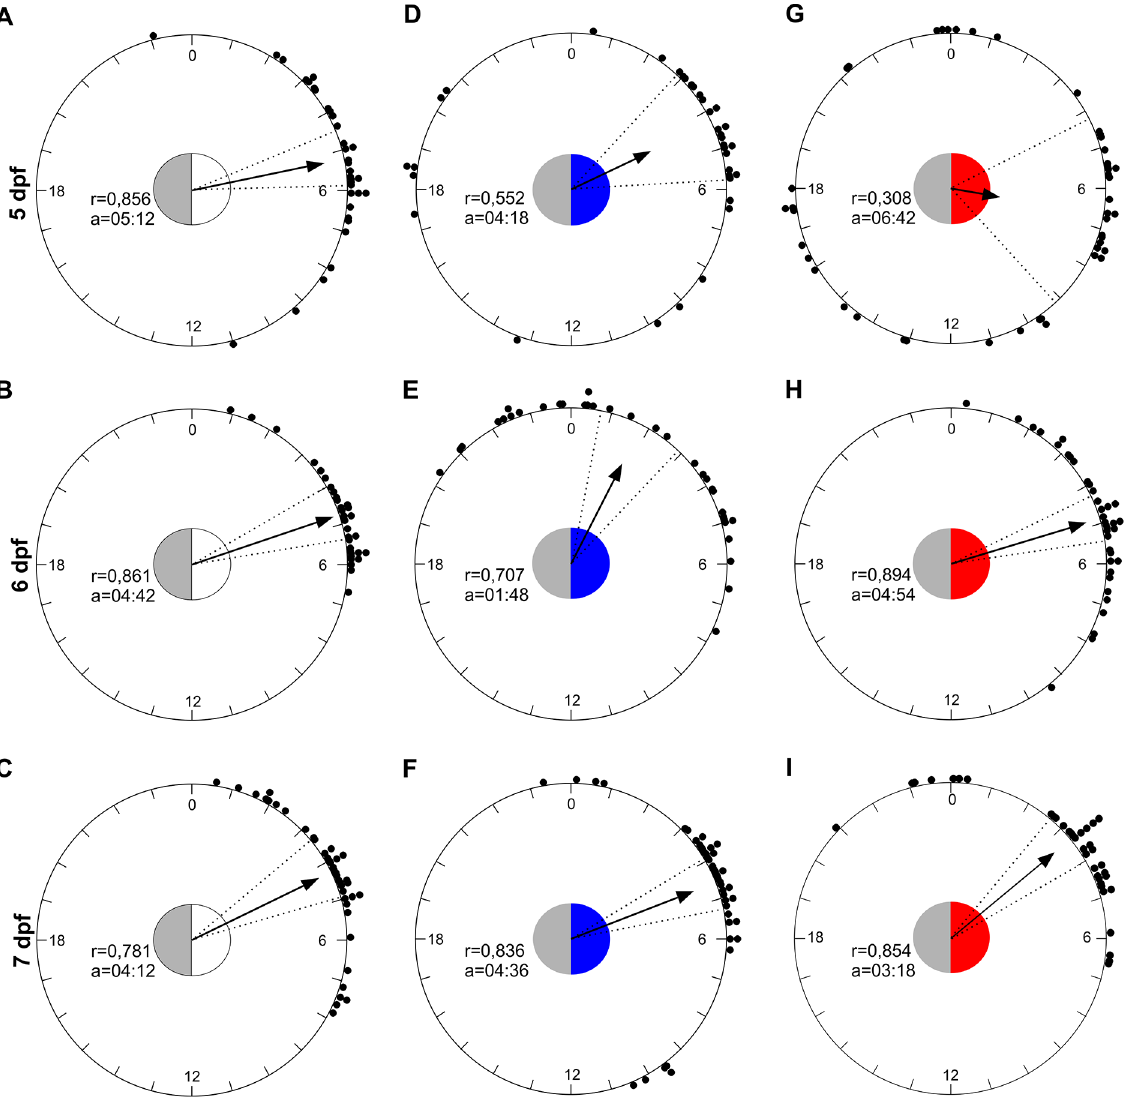
Fig 2. A circular representation of the phases of zebrafish activity across the 24 hours from 5 to 7 dpf under LDW, LDB and LDR. The dots represent the acrophase of each zebrafish larvae. The arrows indicate the average phases represented as vector and in each circle the mean vector length (r) and the mean acrophases (a) in ZT are reported. The circle inside each panel represents critical values of the Rayleigh test (p < 0.05) and the coloured part show the duration of light phase (ZT 0 – 12). The dotted lines represent the confidence intervals.